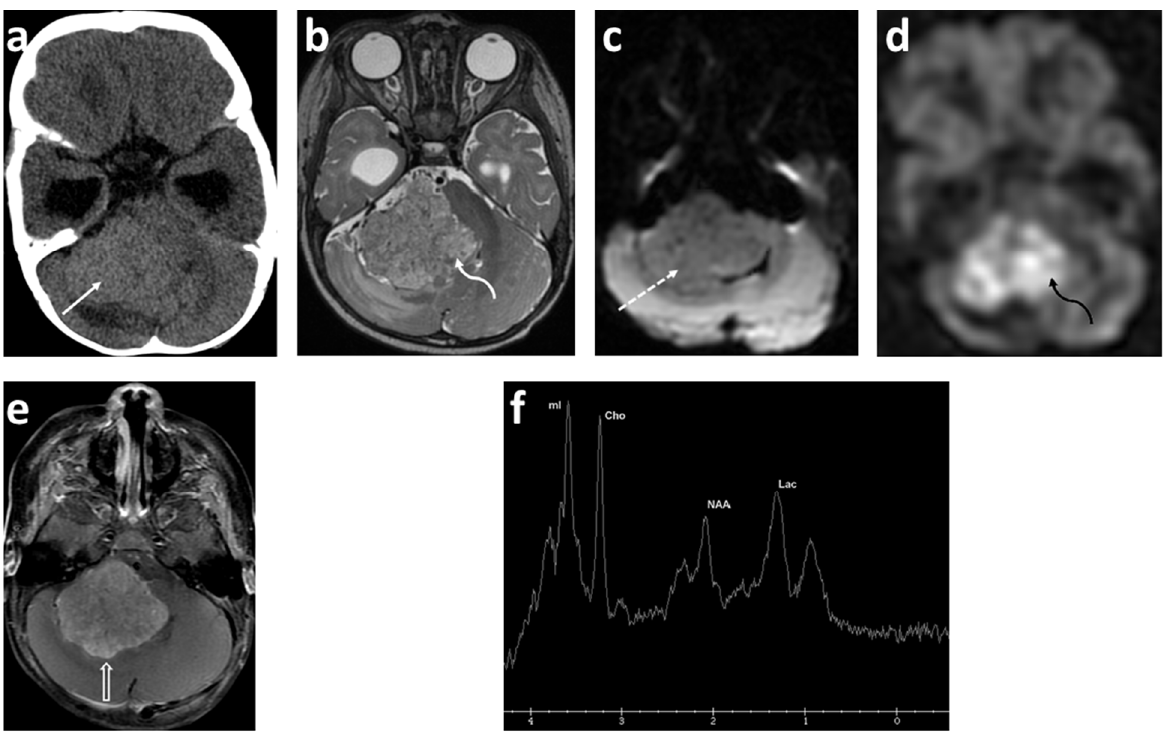
Figure 5. Eight-month-old male referred for bulging fontanelle. Axial CT ( a ); axial T2 ( b ); axial DWI ( c ); axial ASL-PWI ( d ); axial T1 fat saturated post contrast ( e ) images; and short TE 35 millisecond spectroscopy ( f ). CT scan demonstrates mildly hyperdense mass (arrow) with its epicenter in the region of the right foramen of Luschka. The mass is heterogeneously hyperintense on the T2 weighted image (curved arrow). There is no restricted diffusion (dashed arrow). Increased perfusion is identified (curved black arrow) with avid enhancement (open arrow). Spectroscopy demonstrates very high myoinositol (mI), high choline (Cho) and decreased N-acetylaspartate (NAA). There is also elevation of lactate (Lac). Pathology confirmed an atypical choroid plexus papilloma. Author’s institutional human ethics committee/institutional review board guidelines were followed